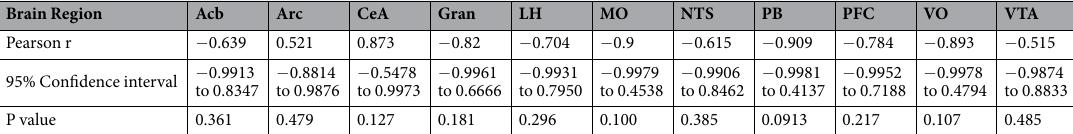
Table 4. Correlations between cFos expression in select brain regions and 3 hr. binge-like food intake levels in the inbred mouse